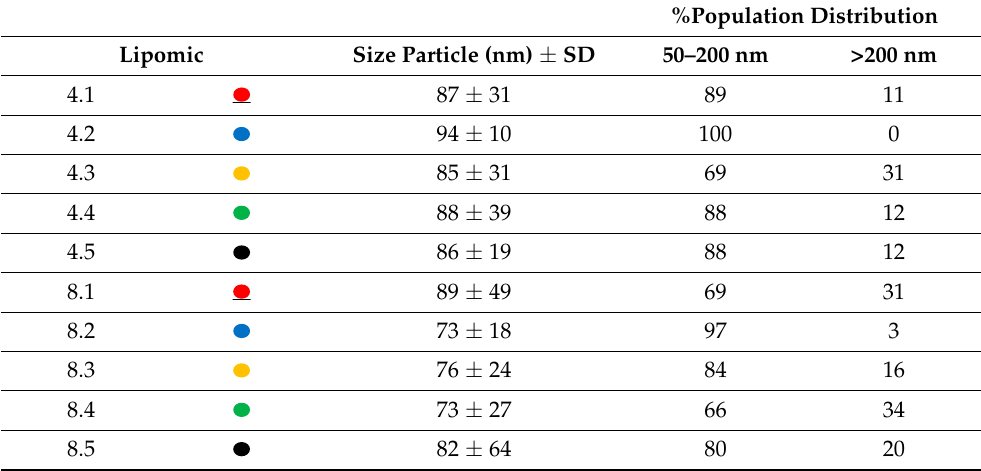
Table 2. Hydrodynamic size distribution of lipomics obtained from the formulations elaborated with the different proportions (% w / w ) of excipients.